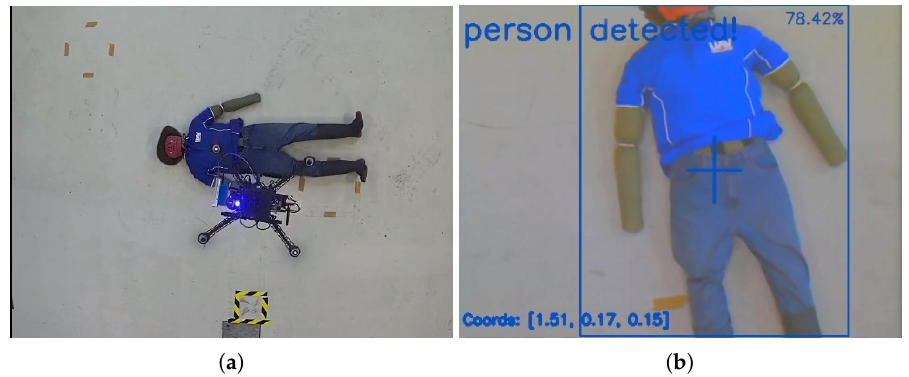
Figure 3. Victim detection trial using the proposed Google MobileNet Single-Shot Detector (SSD) architecture from Chuanqi [48]. Detections with an output score confidence greater than 60% are displayed in the processed frame. ( a ) Top view of the UAV flying above an adult mannequin. ( b )